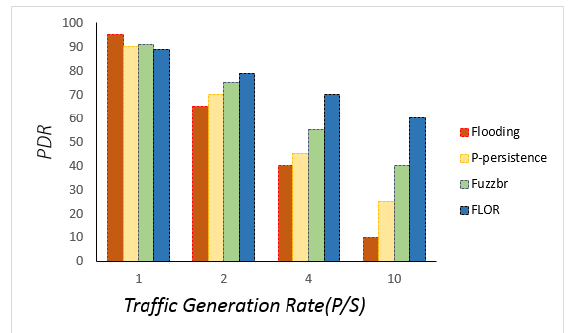
Figure 12. Packet delivery ratio for different traffic generation rates.